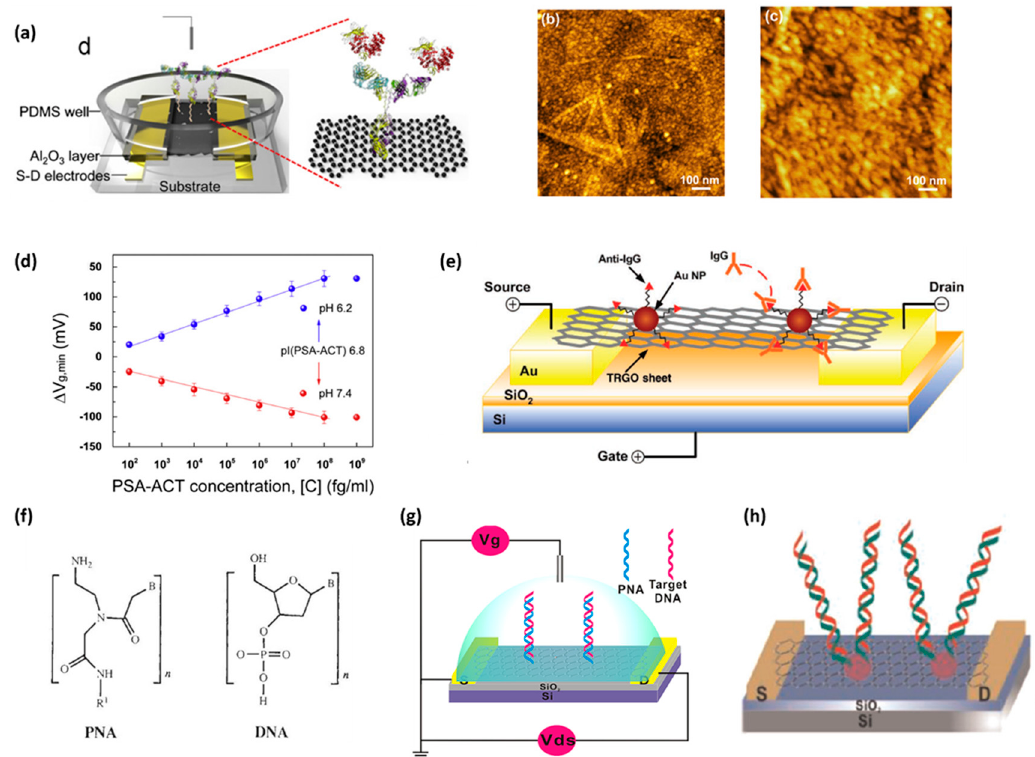
Figure 7. ( a ) prostate specific antigen / a1-antichymotrypsin (PSA-ACT) complex biomarker sensitive rGO FET. ( b ) AFM image of rGO surface after being treated with the PASE linker. ( c ) AFM image of the rGO surface after PSA mAb immobilization and after ETA treatment. ( d ) the electrical conductivity response of the rGO FET to the PSA–ACT complex at di ff erent concentrations. Two sets of PSA-ACT complex solutions were tested (pH = 6.8 and pH = 7.4). ( e ) AuNP anti-IgG conjugates immobilized rGO FET for the detection of IgG. ( f ) The chemical structure of DNA and PNA. ( g ) The RGO FET sensor with the PNA probe for DNA detection. ( h ) AuNP decorated rGO FET sensor for the detection of microRNA. Reprinted with permission from References